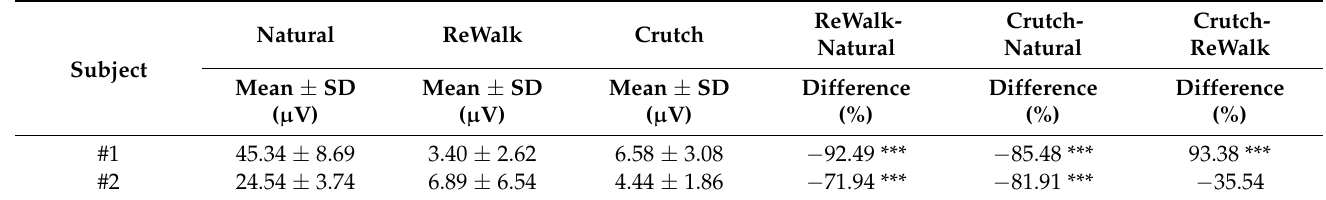
Table 3. Comparison of mean TA EMG WL during the WA